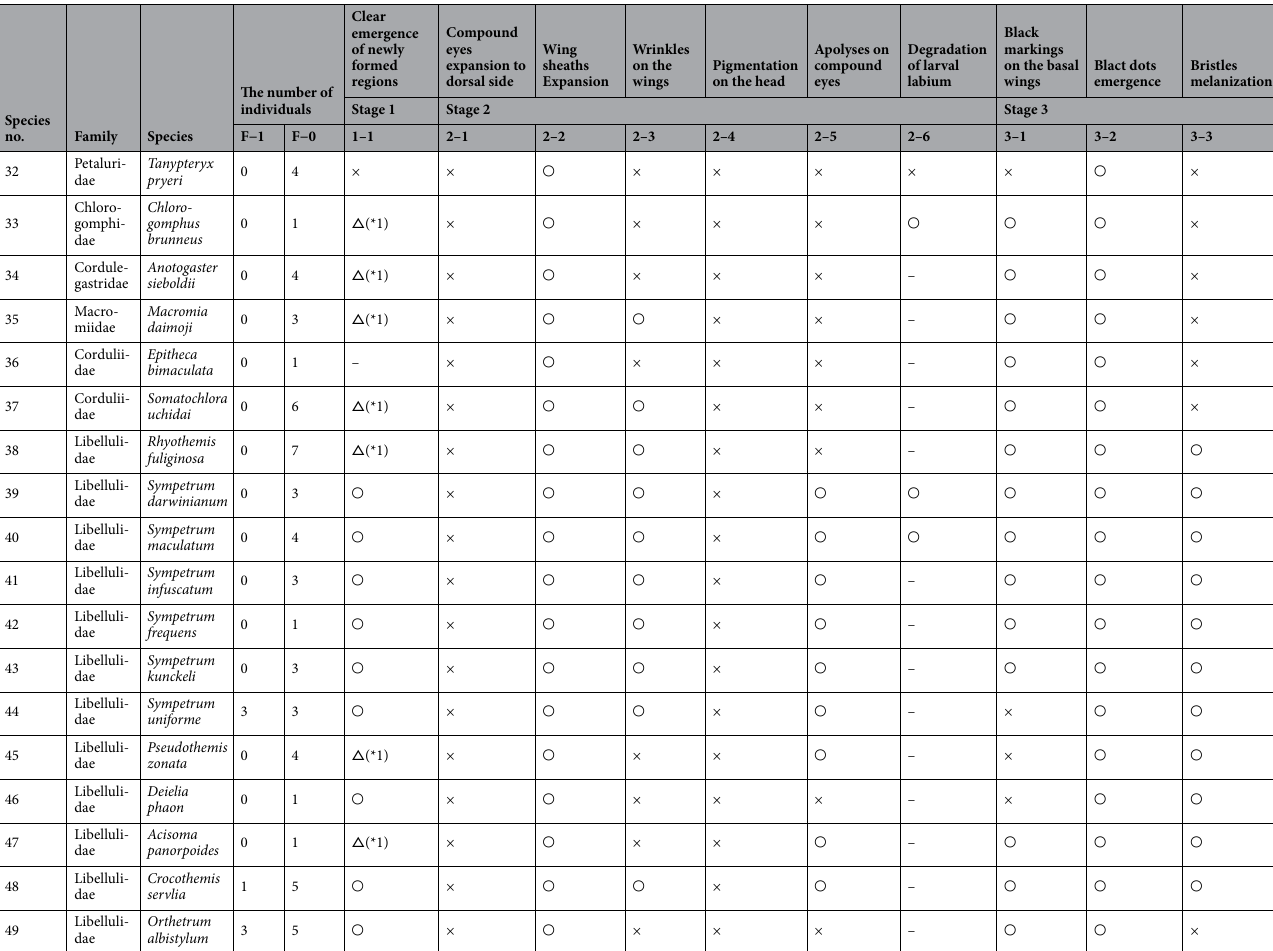
Table 1. Interspecific diversity of morphological changes during F−0 instar larvae of 49 species in this study and the additional two species from other references. ○ : Clearly observed. △ (*1): Difficult to determine the start point when the newly formed regions appear. △ (*2): Gradually expand since stage 1. △ (*3): Difficult to detect in some individuals. ×: Undetectable. Ref. 1: Okude et al. 12 ( Ischnura senegalensis , Coenagrionidae). Ref. 2: Okude et al. 13 (hybrids of I. elegans and I. senegalensis